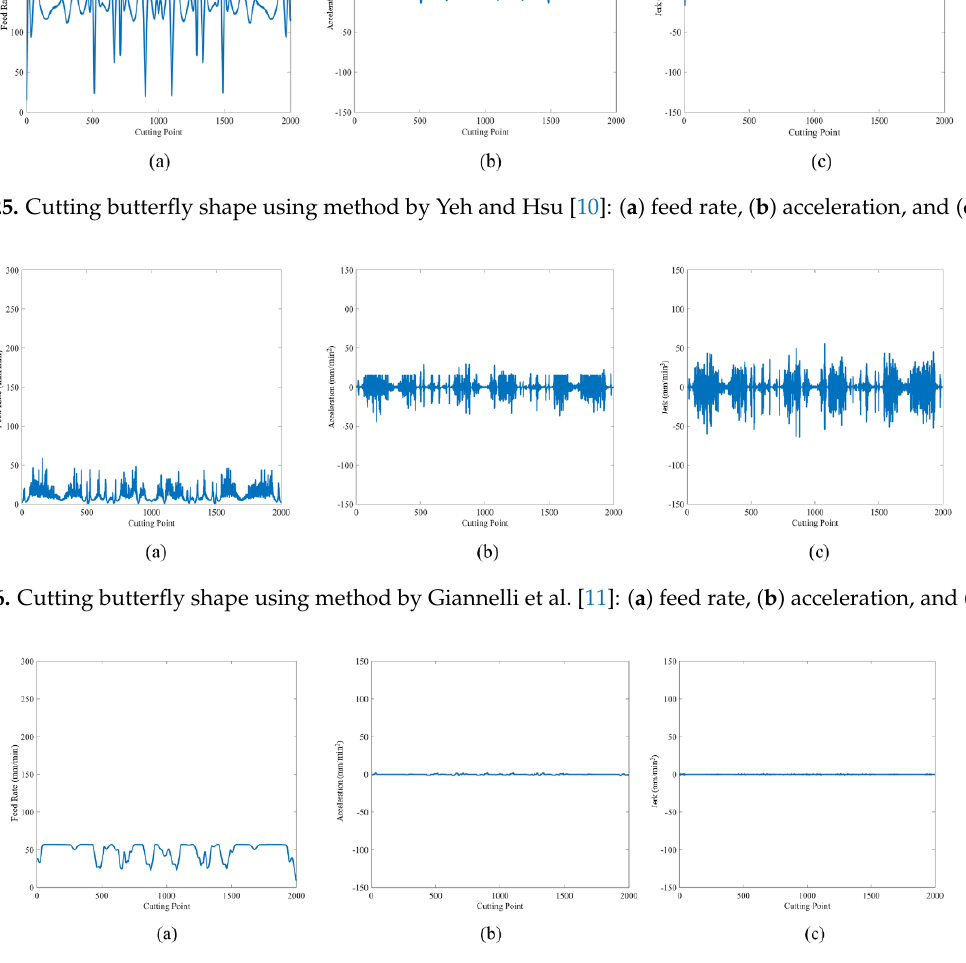
Figure 27. Cutting butterfly shape using our method with maximum feed rate of 58 mm/min: ( a ) feed rate, ( b ) acceleration, and ( c ) jerk.